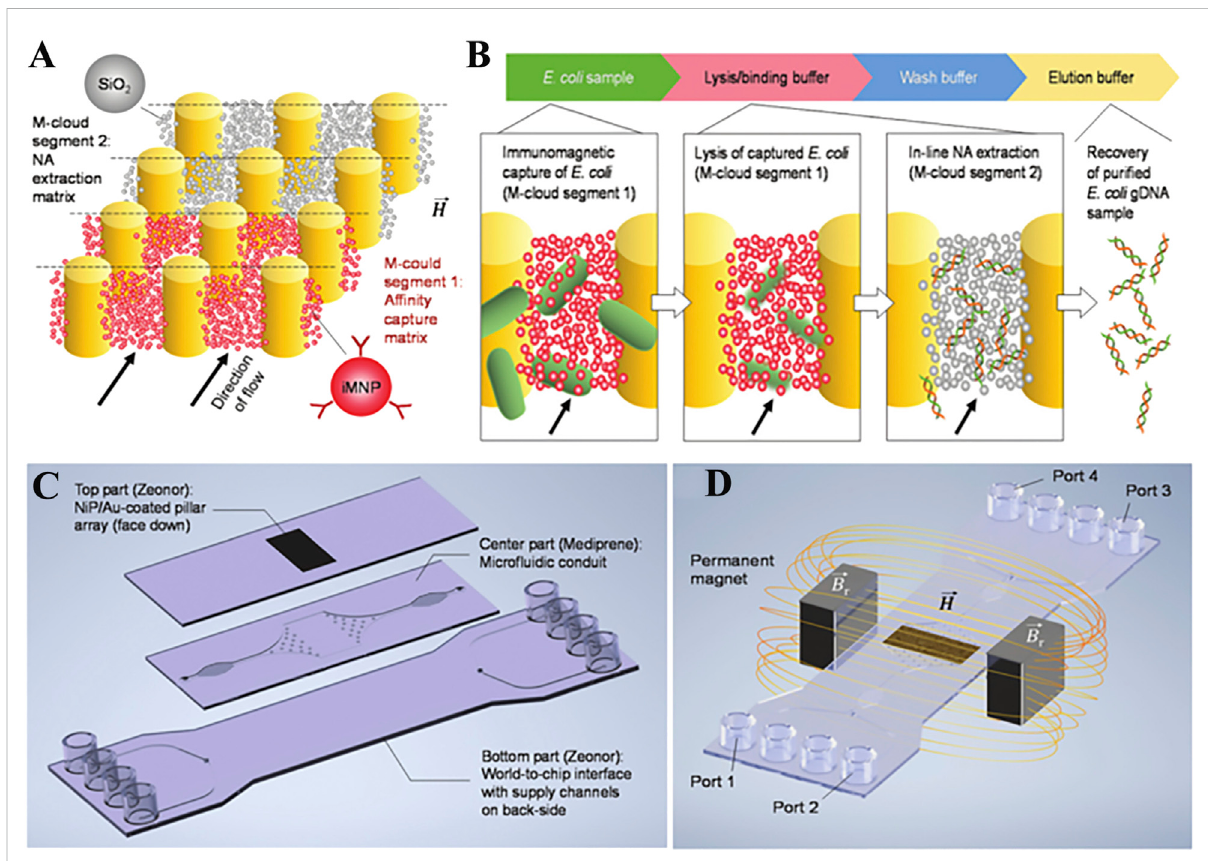
FIGURE 3 Concept of in situ microbial capture and DNA isolation. (A) Schematic illustration of segmented, multifunctional M-cloud con fi guration used within this work. (B) Flow chart detailing the order in which assay components are introduced to the M-cloud, along with illustrations of the main steps. (C) Schema of the micro fl uidic chip developed for process integration. (D) Illustration of the experimental setup used to generate M-cloud capture regions inside the micro fl uidic chip. Copyright 2022 Royal Society of